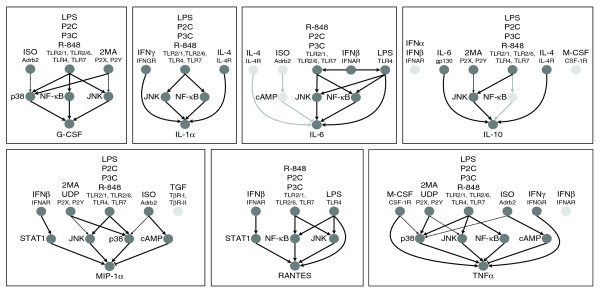
Topologies of signaling networks leading to cytokine releases derived from PCR minimal models and ANOVA analysis. In each panel, nodes in the upper row represent ligands that significantly regulate respective cytokines (ANOVA). Nodes in the middle row represent significant pathways identified by PCR minimal models. Edges between top and middle rows represent significant signaling pathway regulation by the given ligands (ANOVA). Edges between top and bottom rows, or middle and bottom rows, represent significant participation identified by PCR minimal models. Weak activation of signaling pathways is indicated by dashed edges. Light gray: pathways demonstrated in the literature to not play any role (false positives).